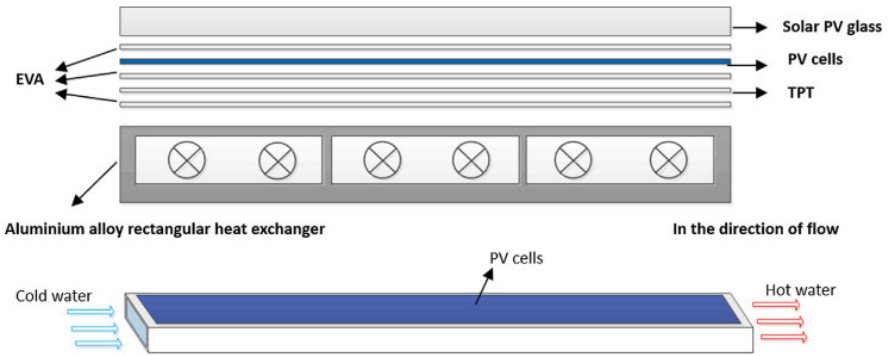
Figure 16. The cross-sectional view of typical heat receiver with internal channels.